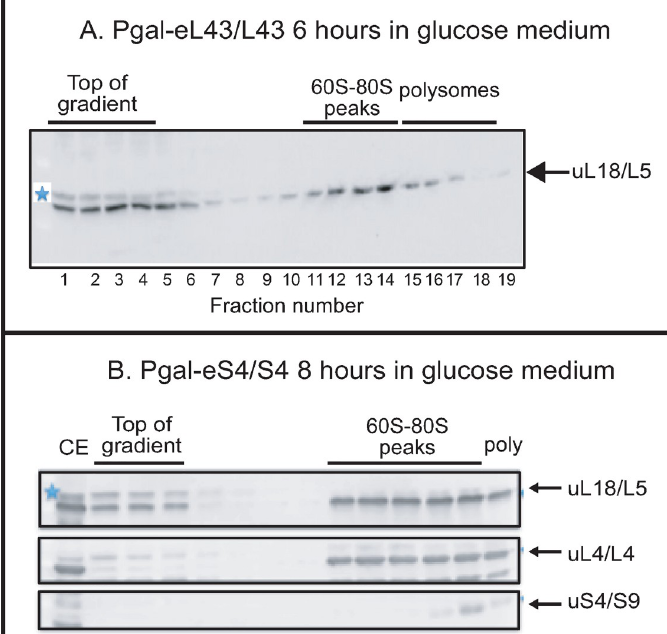
PLOS ONE | https://doi.org/10.1371/journal.pone.0222479 January 27,